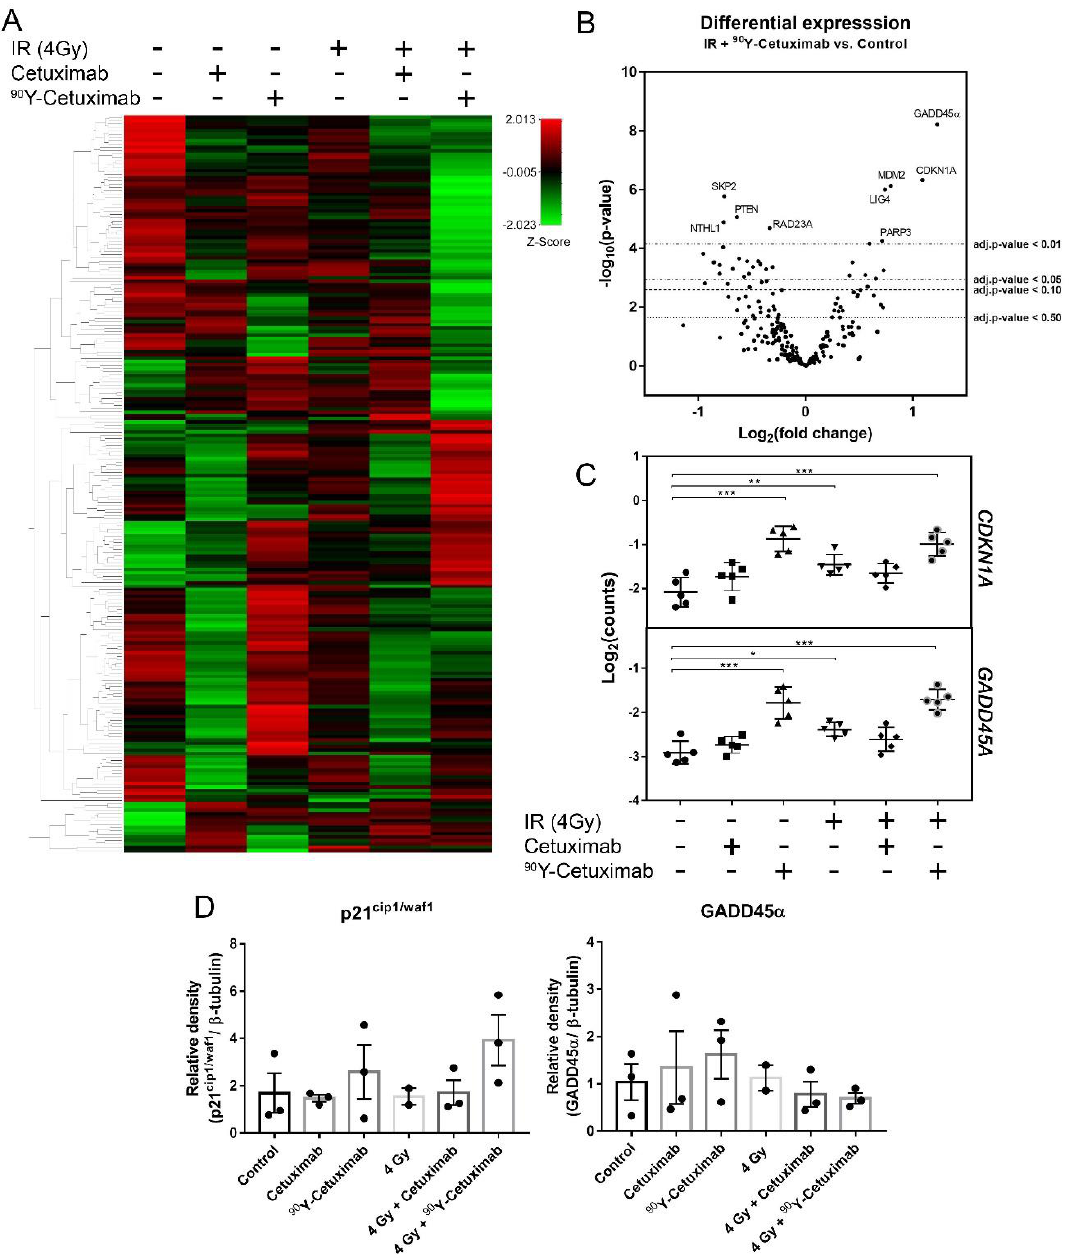
Figure 3. mRNA and protein expression of DDR genes upon mono- and combination treatment with external irradiation and 90 Y-(un-)labeled Cetuximab. Heat map of mRNA expression of DDR related genes determined by nCounter TM ( n = 5) ( A ). Differential mRNA expression of the combination treatment using external irradiation (4 Gy) with 90 Y-Cetuximab relative to control ( B ). Log 2 Counts of two candidate genes: CDKN1A and GADD45A under different treatment arms ( C ). Solid lines and error bars denote mean and standard deviation, respectively. One-way ANOVA followed by post-hoc test with Sidak’s correction for the comparison between the treatment groups and control was performed (*: p < 0.05, **: p < 0.01, ***: p < 0.001). Protein expression of CDKN1A encoding protein, p21 cip1/waf1 , and GADD45 α assessed by immunoblotting ( n = 3) ( D ). Bars and error bars represent mean and standard error of mean, respectively. As proteins encoded by GADD45A (GADD45 α ) and CDKN1A (p21 cip1/waf1 ) are es- sential components in cell cycle arrest and programmed cell death mechanisms,